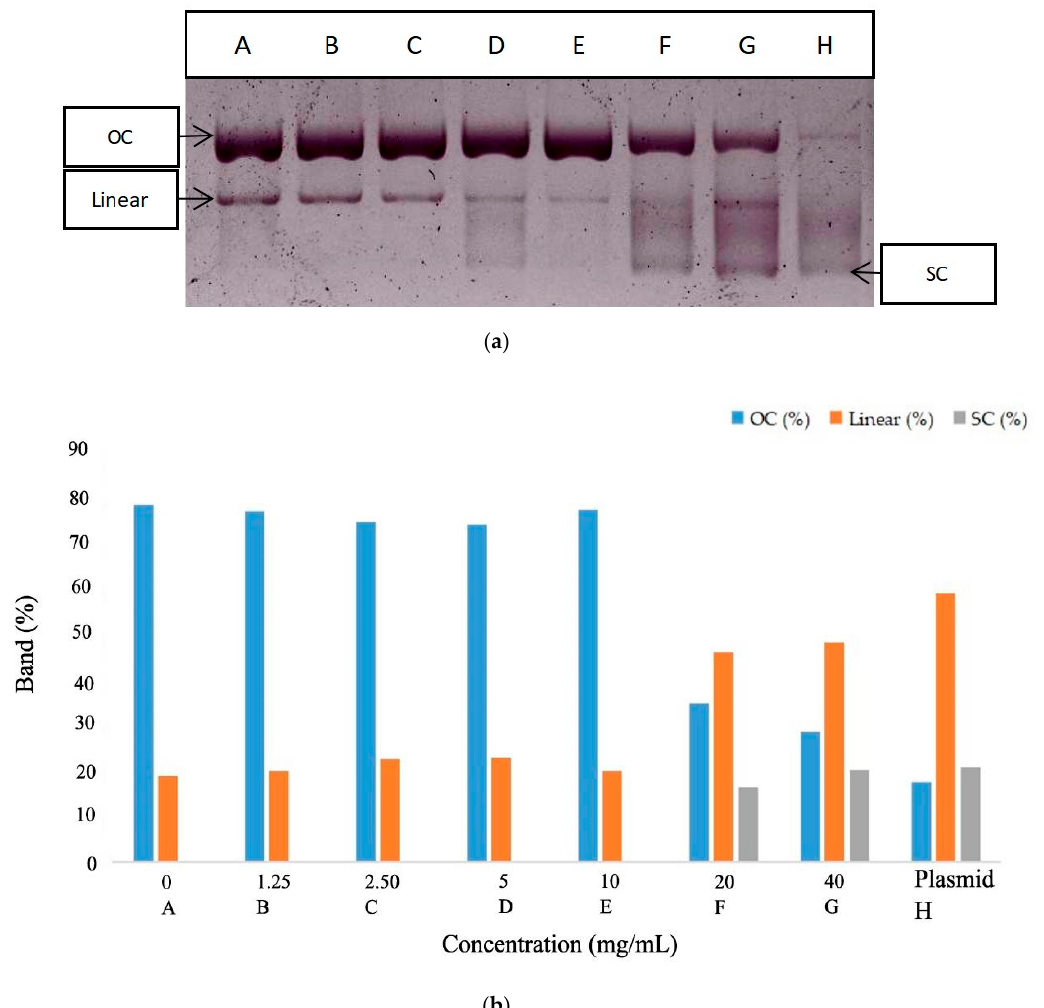
Figure 2. Electrophoretic monitoring of topological structure changes of the plasmid DNA (pBR322) induced by M. oleifera leaves infusion ( a ). Concentration-dependent inhibitory effects of M. oleifera leaves infusion against DNA damage expressed in % Band ( b ). Note: The letters A–H indicate the leaf infusion concentration (see Table 2).